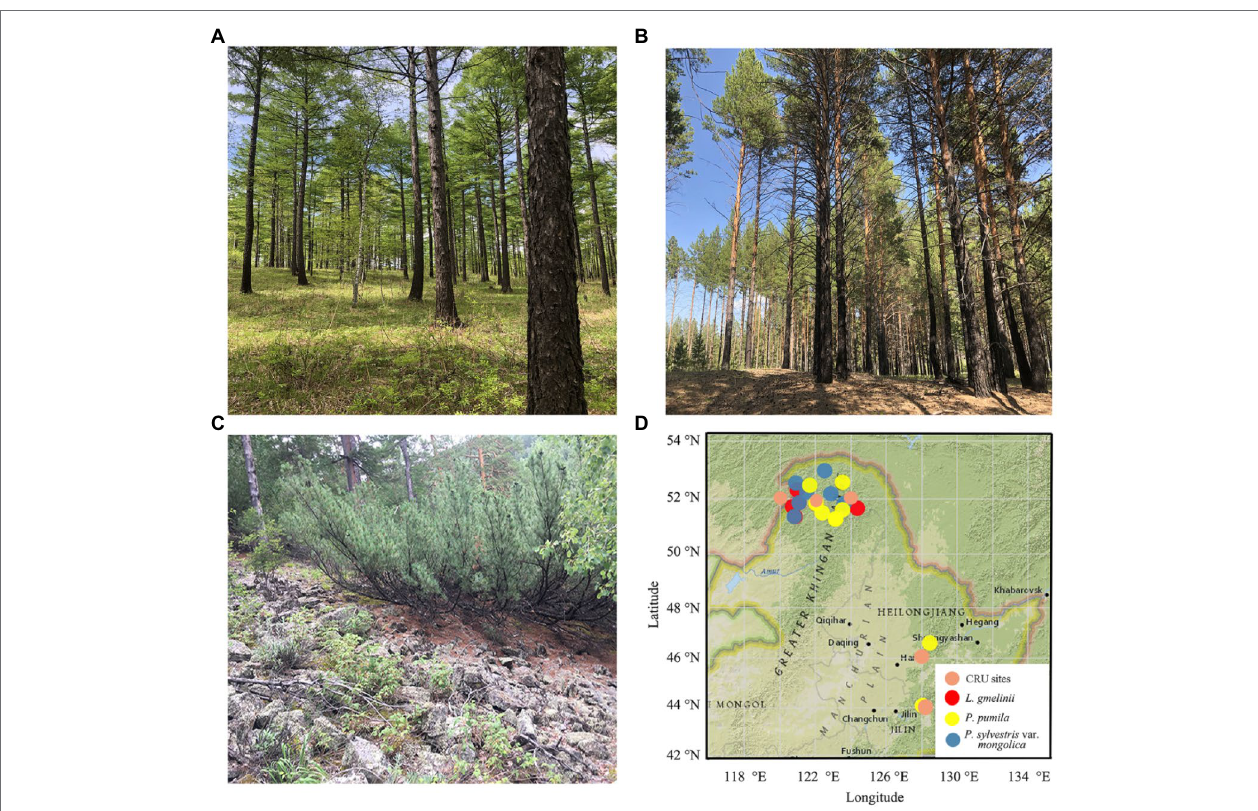
FIGURE 1 | Field photos ( A : Larix gmelinii ; B : Pinus sylvestris var. Mongolica ; C : Pinus pumila ) and location map of tree–ring sampling sites (D) (red circle, Larix gmelinii ; yellow circle, Pinus pumila ; blue circle, Pinus sylvestris var. mongolica ) in the northeast of China. Fieldwork was conducted from 2015 to 2018 at 26